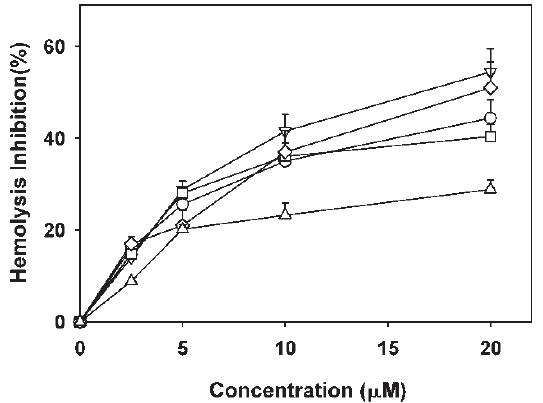
Figure 3. The protective effects of epicatechin ( L - L ), catechin ( A - A ), Dimer B2 ( S - S ), and 3 0 - O -methyl epicatechin ( A - A ), expressed as percent inhibition of erythrocyte hemolysis. Ascorbic acid ( D - D ) was used as a reference compound. Data are expressed as means ^ SEM of n ¼